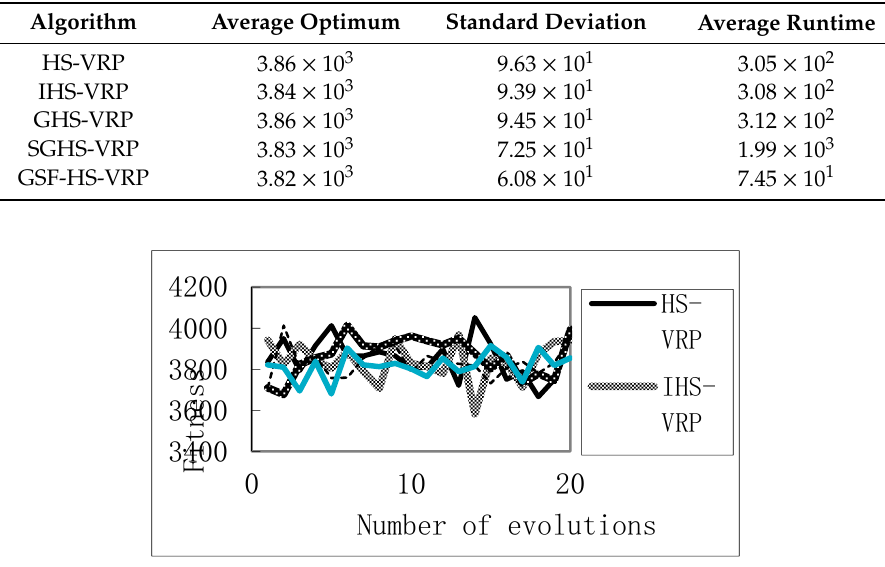
Table 8. Comparison results at fixed iteration times.